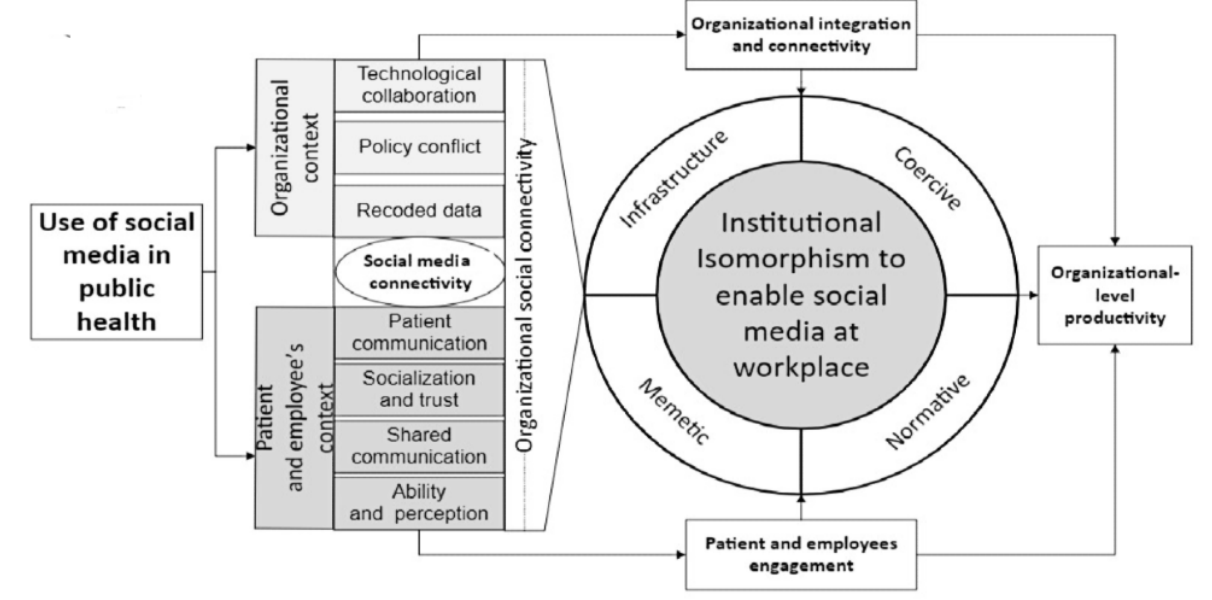
Figure 3. Social Media Organizational Productivity